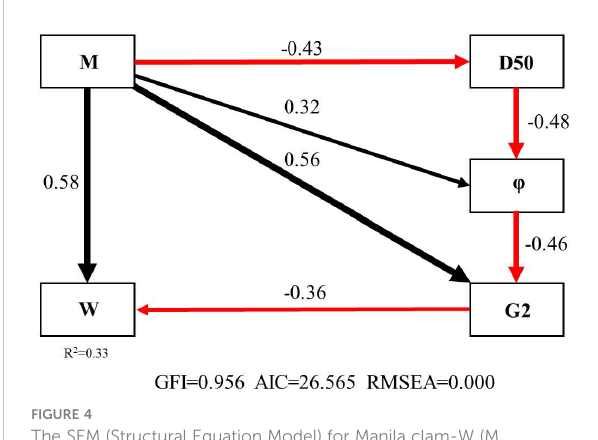
FIGURE 4 The SEM (Structural Equation Model) for Manila clam-W (M 、 G2 、 j 、 D50 and W represent the biomass of Manila clam, the biomass of functional group G2, water content, particle size and the statistic of ABC curve, respectively. The black arrow indicates a positive effect, and the red one indicates a negative